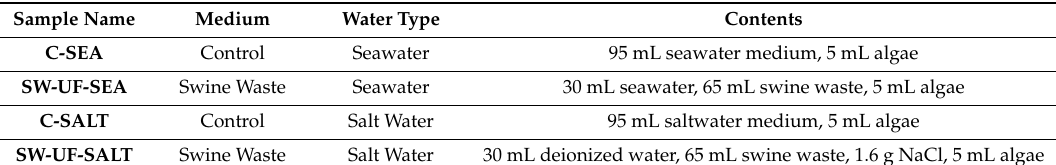
Table 1. Microalgae growth media